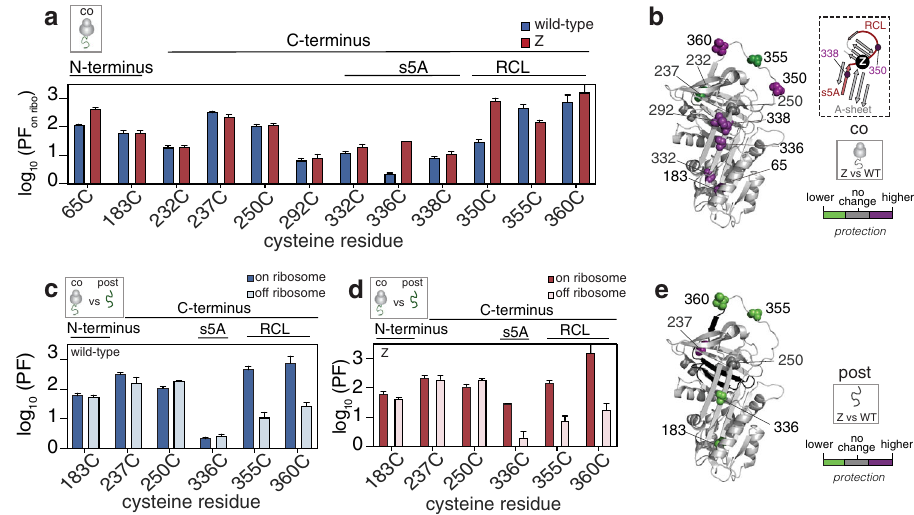
Fig. 6 Co-translational folding intermediates persist post-translationally. a Protection factors (PF) calculated for the co-translational folding intermediates formed by wild-type and Z RNCs as derived from PEGylation kinetics ( n = 5 biological repeats). b Difference in protection in the Z ’ s co- translational folding intermediate relative to that of wild-type, as mapped onto AAT ’ s native structure. (inset) A magni fi ed view of AAT ’ s central A-sheet region, highlighting the location of the s5A/RCL region and the Z mutation. This region is implicated in AAT folding (see text). c A comparison of the protection factors for wild-type ’ s co-translational folding intermediate (on ribosome) and post-translational folding intermediate (off ribosome) for a series of cysteine positions. d As described for c but shows Z. e Difference in protection in Z ’ s post-translational intermediate relative to that of wild-type, as mapped onto AAT ’ s native structure. Data are presented as mean values + / −